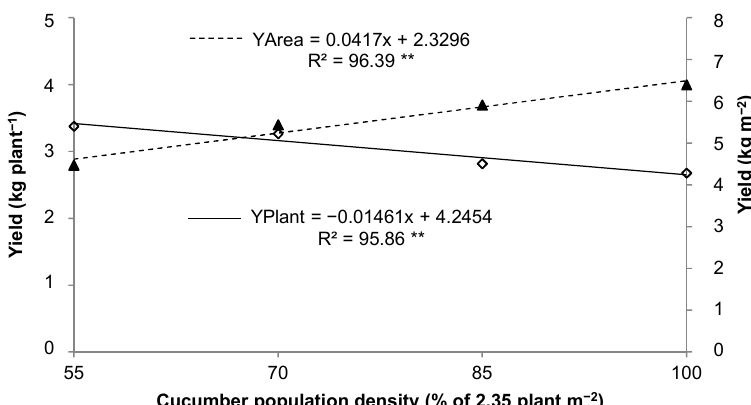
Figure 5. Number of fruits per plant and area of cucumber as a function of population densities. ◊ Fruits plant −1 ; ▲ Fruits m −2 . ** p ≤ 0.01 in F test.